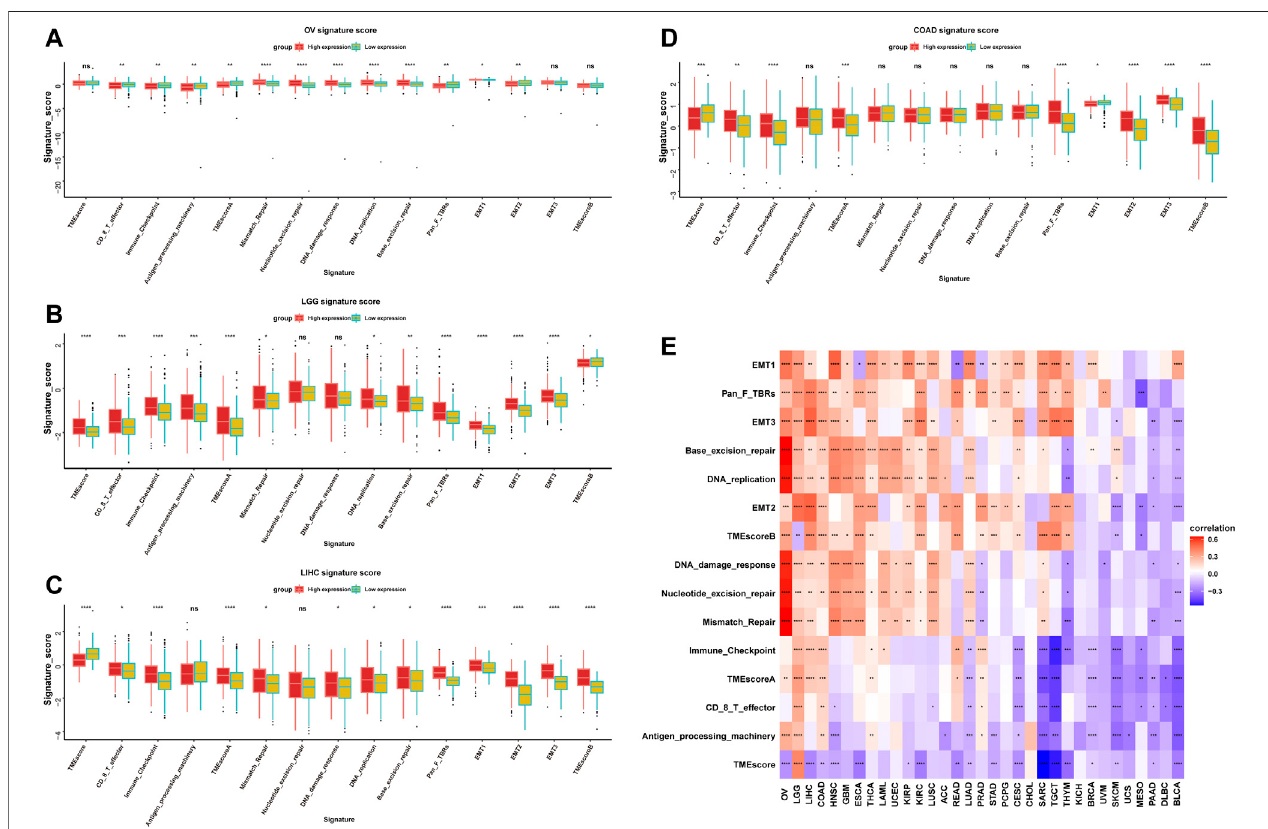
FIGURE 8 | TME-related pathway analysis. (A – D) The scores of TME-related pathways in high- and low-ISYNA1 groups in indicated tumor types. (E) The correlation analysis between ISYNA1 expression and TME-related pathways in pan-cancer. Red represents positive correlation, and blue represents negative correlation. The darker the color, the stronger the